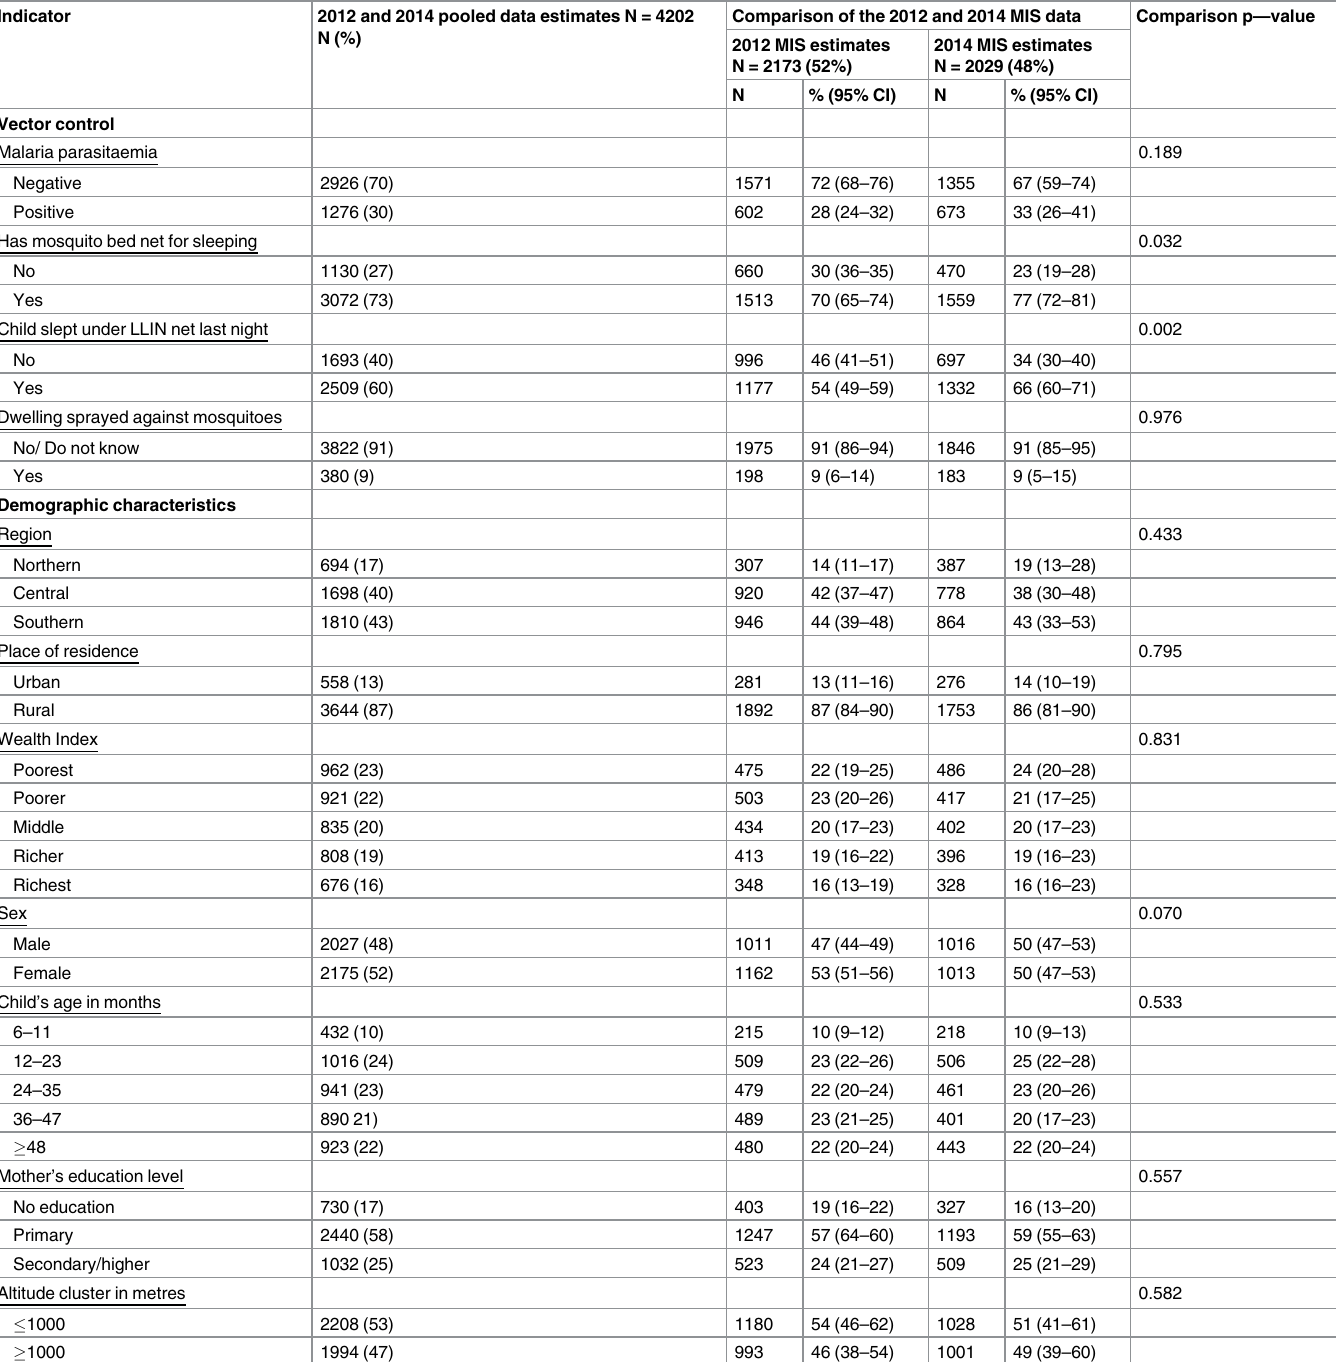
Table 1. Comparison of vector interventions and sociodemographic indicators between the 2012 and 2014MISs. Indicator 2012 and 2014 pooled data estimatesN = 4202 Comparison of the 2012 and 2014MIS N (%)